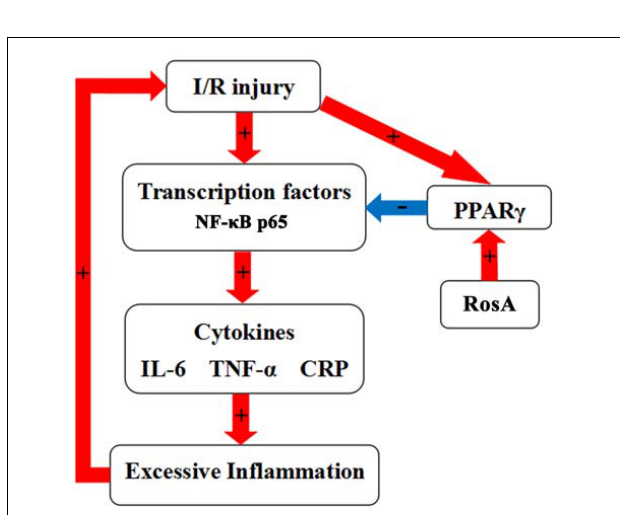
FIGURE 6 | Schematic diagram of the role of the RosA in acute I/R-induced myocardial injury in isolated rat heart.